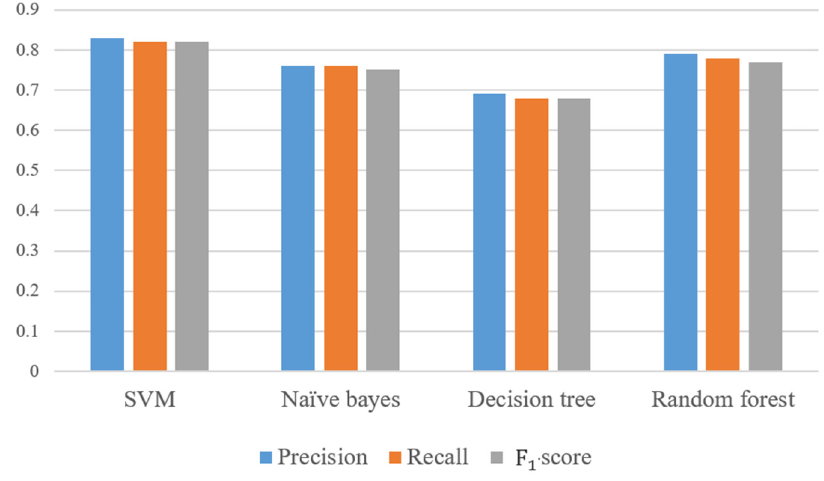
Figure 8. Confusion matrix of the random forest classifier.